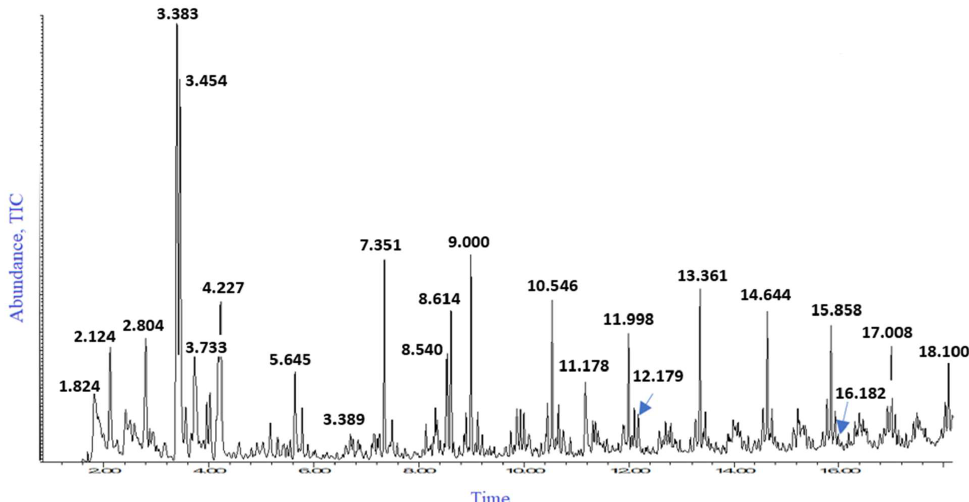
Figure 3. Pyrogram of the extracted EPDM